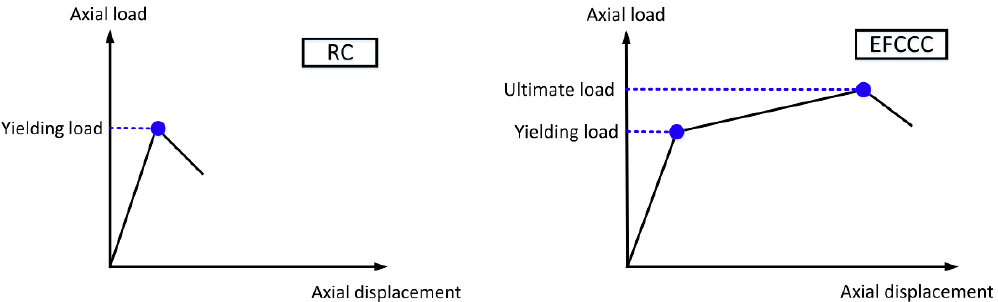
Figure 8. Mechanical behaviors of reinforced concrete (RC) and EFCCC.